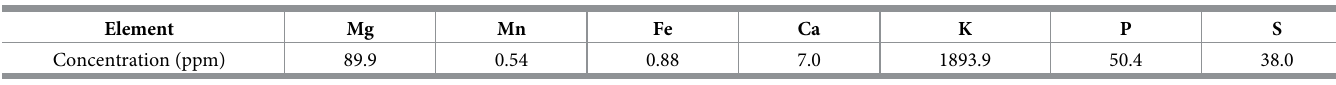
Table 5. The element analysis for the liquid coffee under test. Element